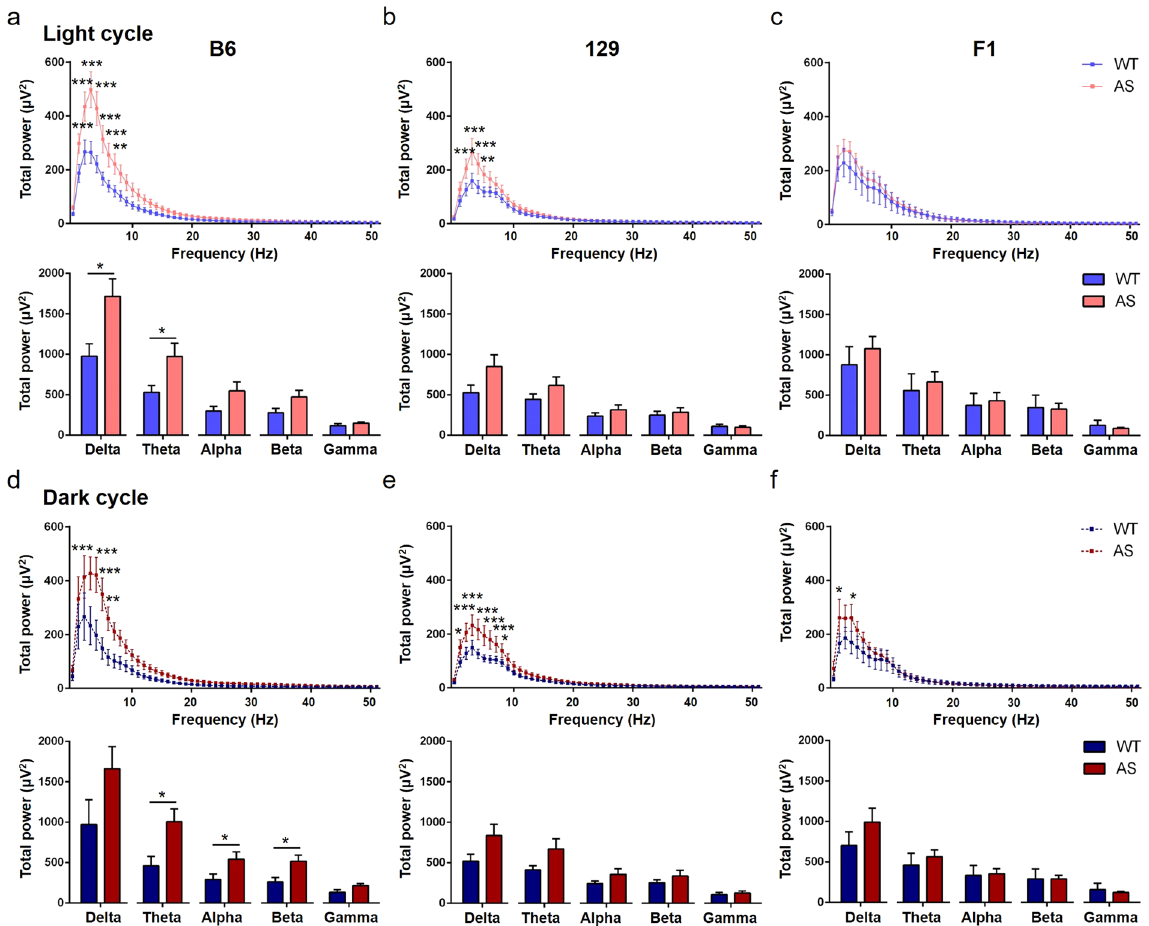
Figure 9. Detailed analysis of EEG spectral cortical power during a representative hour of the light cycle ( a–c ) and dark cycle ( d , e,f ) from AS mice compared to Wt mice. ( a,d ) There was an upward shift of the B6 AS spectral cortical power compared to the B6 Wt mice during both dark and light cycle. This shift was primarily driven by increased power in the delta and theta frequency range (n = 9–11/group). During the dark cycle ( d ), significant increases were also seen in the summed alpha and beta spectral bands in B6 AS mice. ( b,e ) An upward shift in power was also seen in 129 AS compared to 129 Wt mice, driven by increased power in the 1–7 Hz range, although no significant differences were seen in the summed frequency bands (n = 8–10/group). ( c,f ) No significant changes were seen between F1 AS and Wt mice during the light cycle, however increased power was seen in the delta frequency range in F1 AS mice during the dark cycle when compared to F1 Wt mice (n = 3–6 / group). 2-way ANOVA was used to compare the individual frequencies across the spectrum. Student’s t-test was used to compare between individual frequency bands and data are presented as the mean ± SEM; * p < 0.05, ** p < 0.01, *** p <